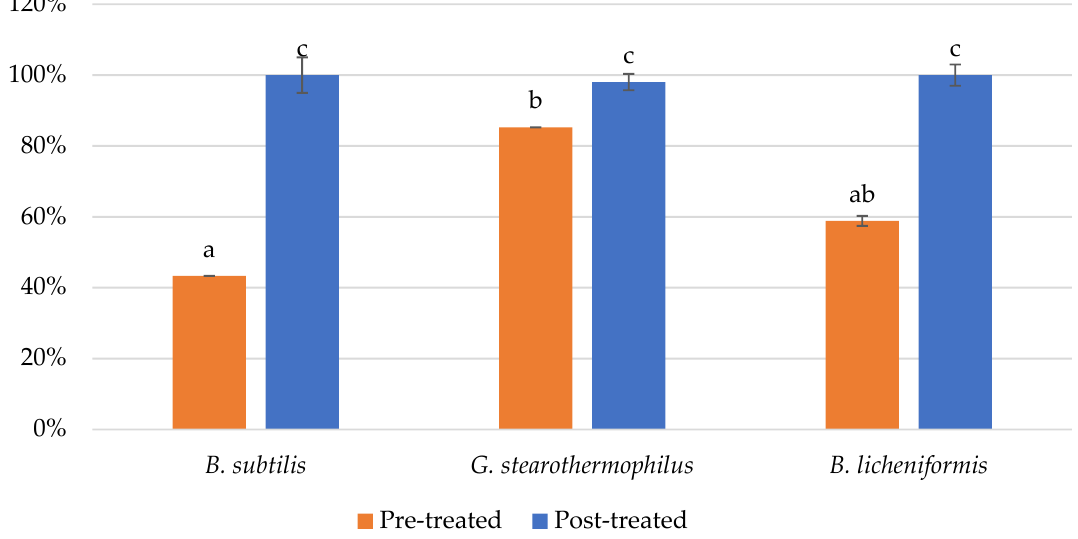
Figure 4. Disease incidence of A. alternanta pre-infection treatment and post-infection treatment by Bacilli supernatants comparing mean significance with Tukey HSD. Small letters indicate the statistically different results groups.